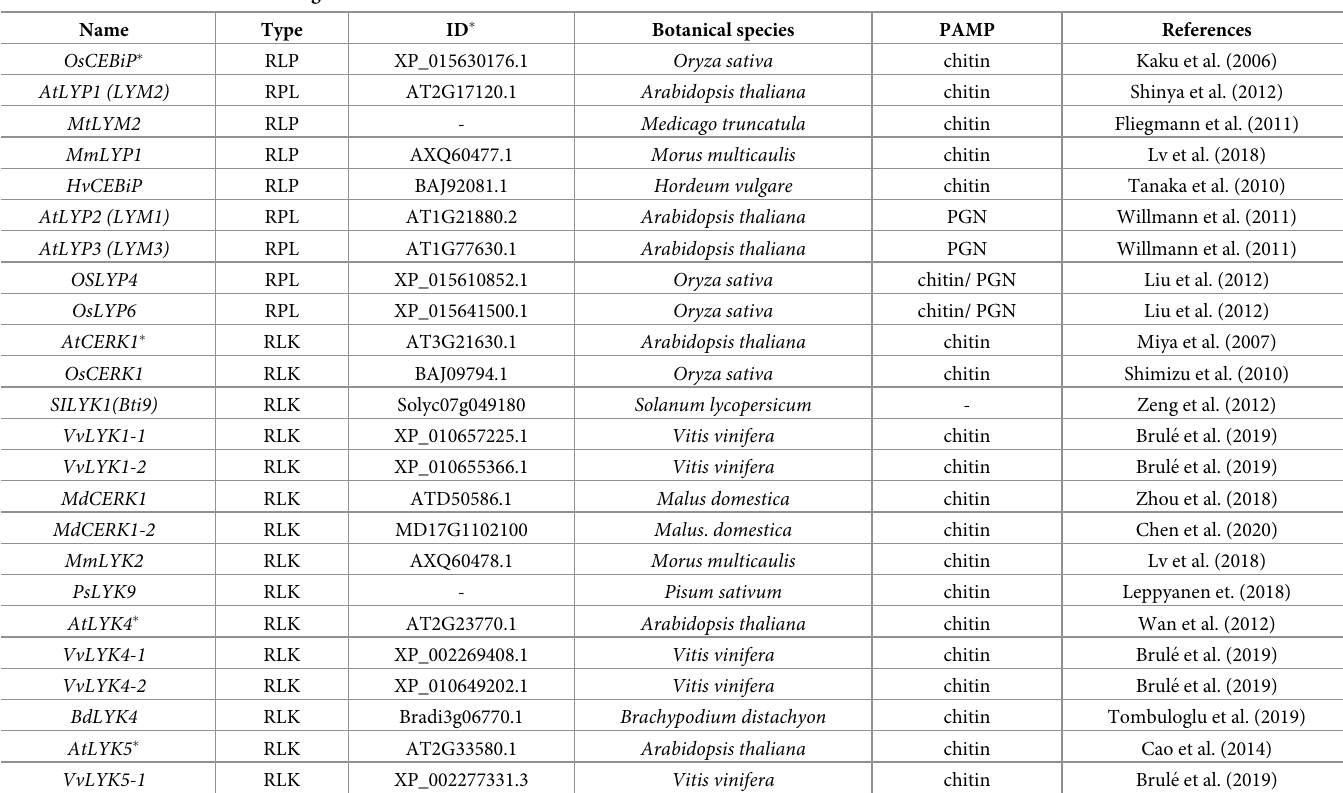
Table 1. Reference PRRs and homologues.